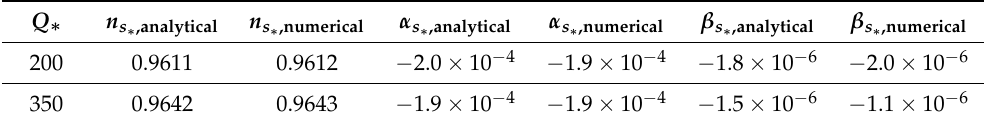
Table 2. Analytical estimation of n s , α s and β s , along also with their full numerical determination, for the 2 cases considered in Table